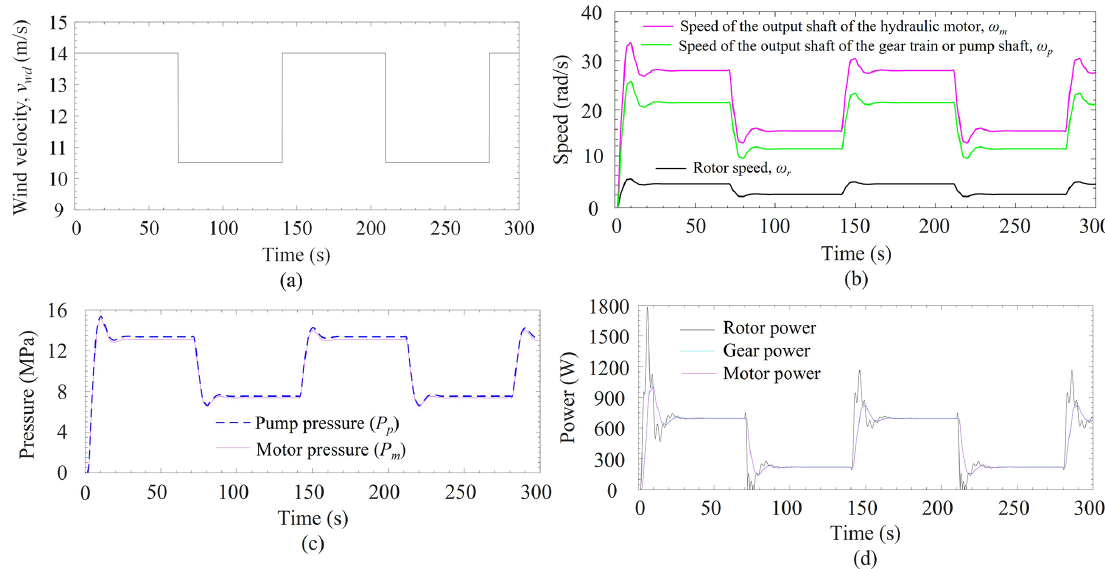
Figure 6. (a) User-defined variable wind velocity (Mahato et al., 2018). (b) Speed of turbine rotor, hydraulic pump, and hydraulic motor ( ω r , ω p , and ω m ). (c) Pressure at pump and motor plenum ( P p and P m ). (d) Power developed at rotor, gear, and motor